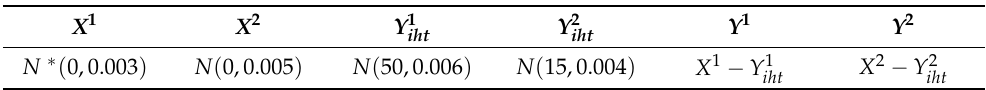
Table 2. PQRVs and IPQRVs of Example 2 and the distribution of